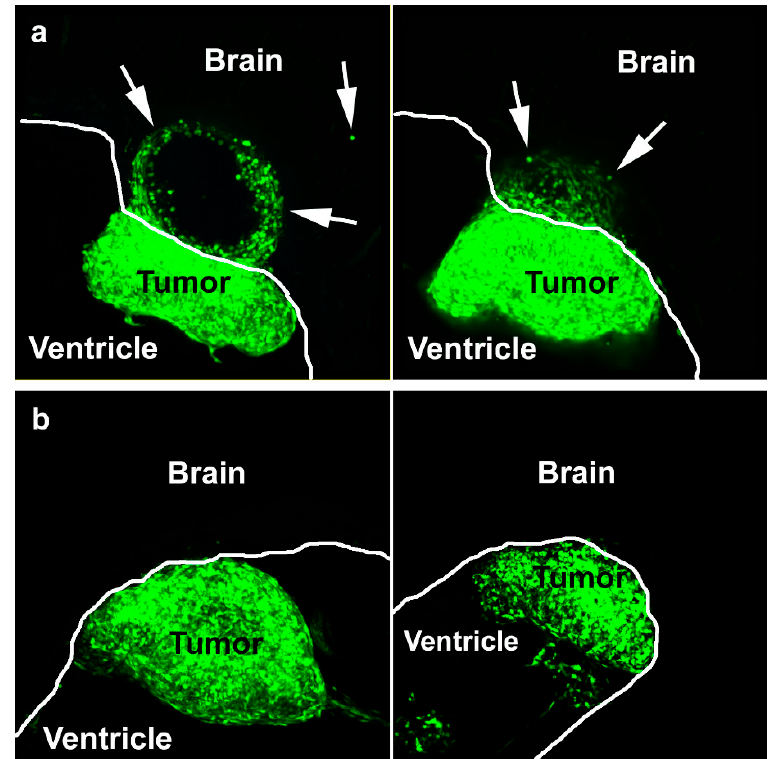
Figure 5. L1-decorated exosomes initiate brain invasion. ( a ) Two examples of invasion of GFP-expressing T98/shL1 cells beyond the tumor margin (arrows) when mixed with T98G L1-decorated exosomes. ( b ) Two examples of GFP expressing T98G/shL1 tumors where cells did not invade the brain beyond the tumor margin when mixed with L1-reduced T98G/shL1 exosomes. White lines show the surface of the brain wall along the ventricle. Brain tissue is unstained. Images are confocal maximum projections of z-stacks.